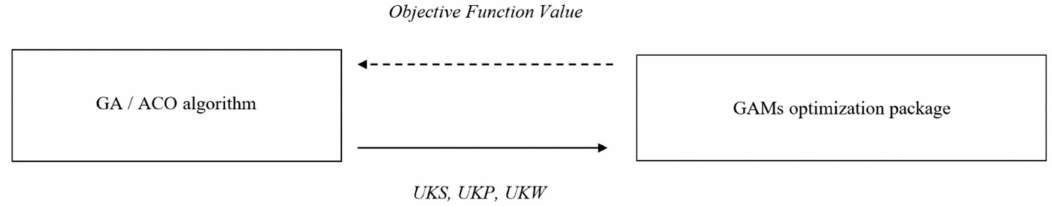
Figure 2. The framework of the proposed